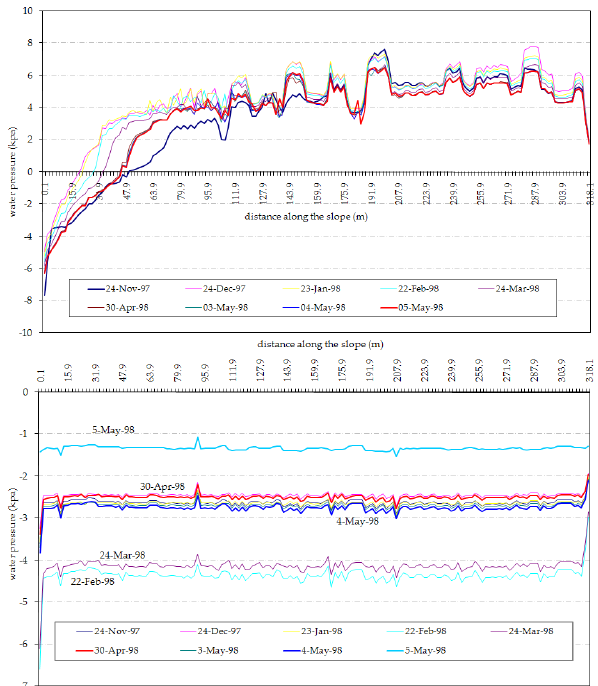
Figure 11. Pore-water pressures performed at (a) 3m and (b) 0.7m below the ground surface.